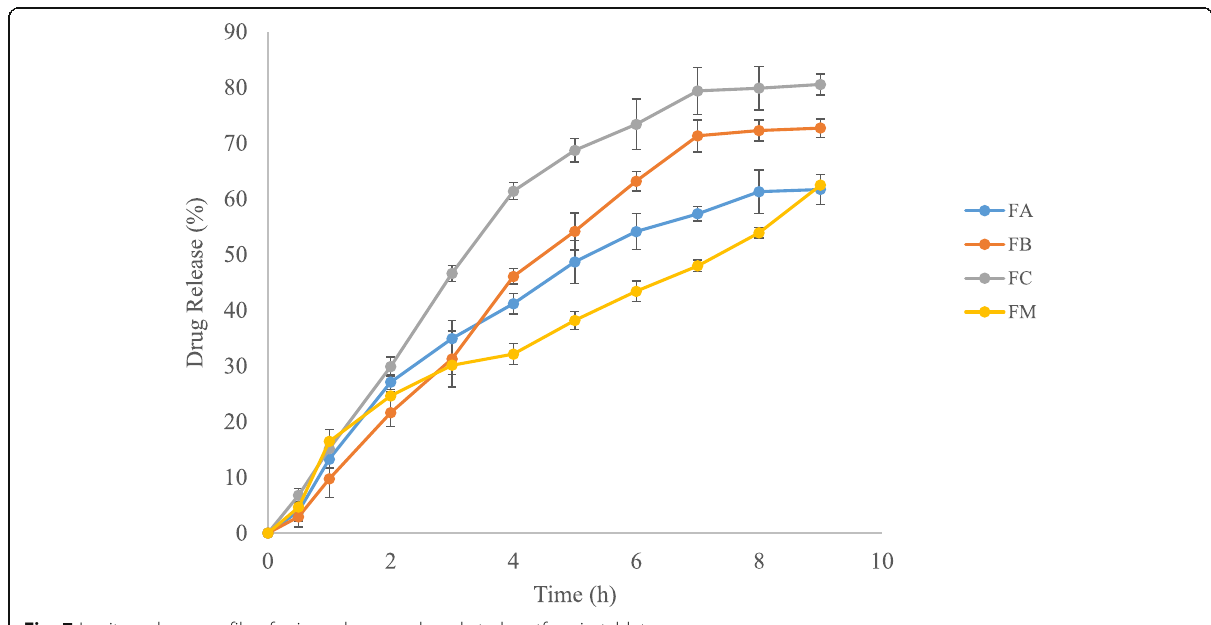
Fig. 7 In vitro release profile of microspheres and marketed metformin tablets